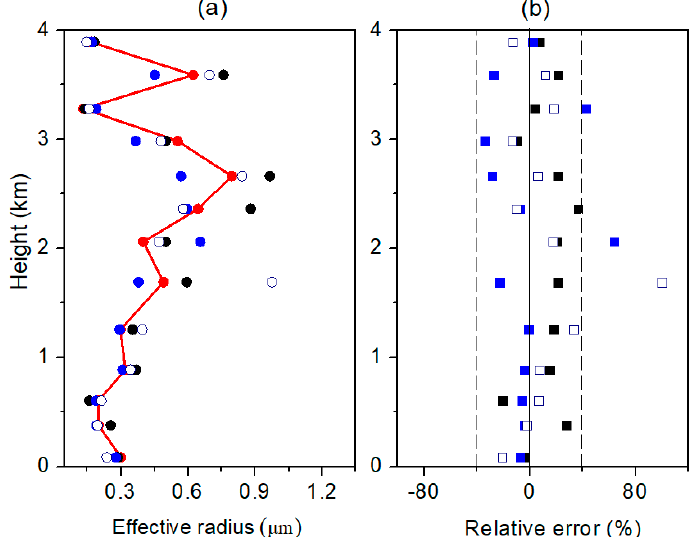
Figure 8. ( a ) Measured aerosol effective radius, inversion effective radii and ( b ) the corresponding relative errors at the vertical heights.